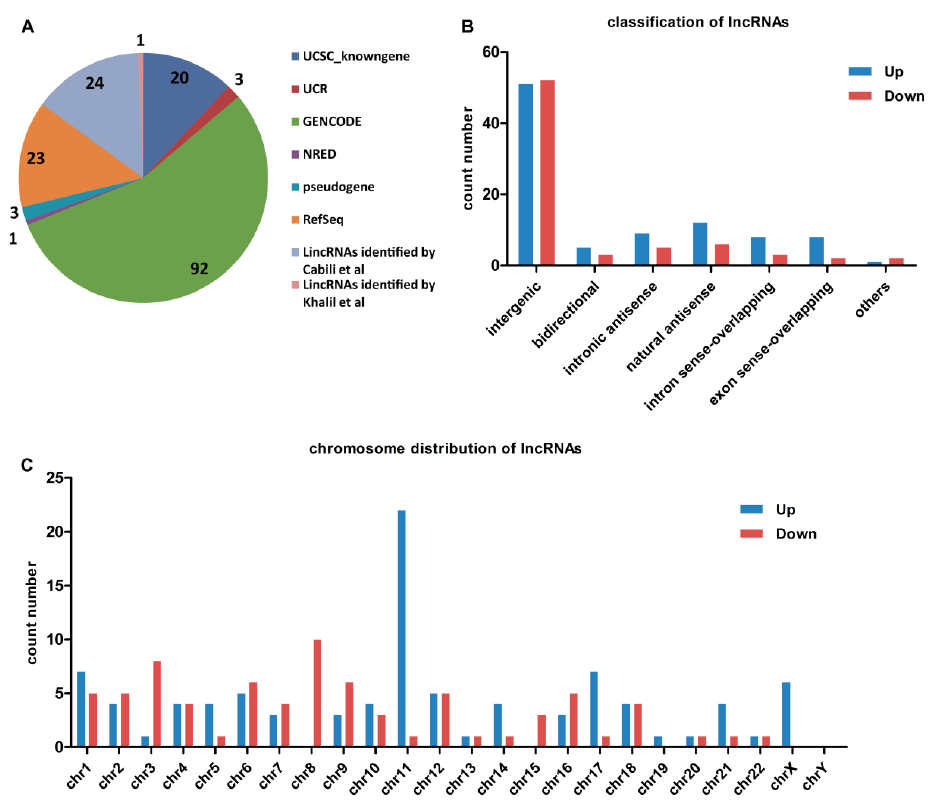
Figure 1. Distribution of aberrantly expressed long non-coding RNAs (lncRNAs) in the high metastatic potential nasopharyngeal carcinoma (NPC) cell lines when compared with low metastatic potential NPC cell lines. ( A ) pie chart showing the relative numbers of lncRNAs based on the most authoritative databases; ( B ) distribution of dysregulated lncRNAs according to their classification; and ( C ) lncRNA profiles on human chromosomes. The number of deregulated species, including detailed upregulated and downregulated lncRNAs are shown. chr: chromosome.